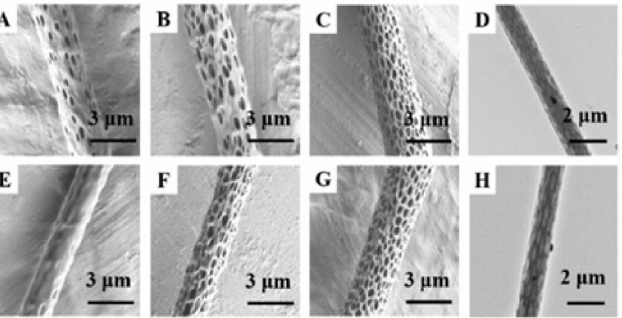
Figure 5. SEM images of porous PLA nanofibers with (DCM/EtOH) ( A ) 90:10 (V/V), ( B ) 95:5 (V/V), and ( C ) 100:0 (V/V). Porous PLA nanofibers were electrospun at ( E ) 20% RH, ( F ) 50% RH, ( G ) 80% RH. TEM images: ( D ) and ( H ). Reprinted with permission from ref. [64]. Copyright 2021